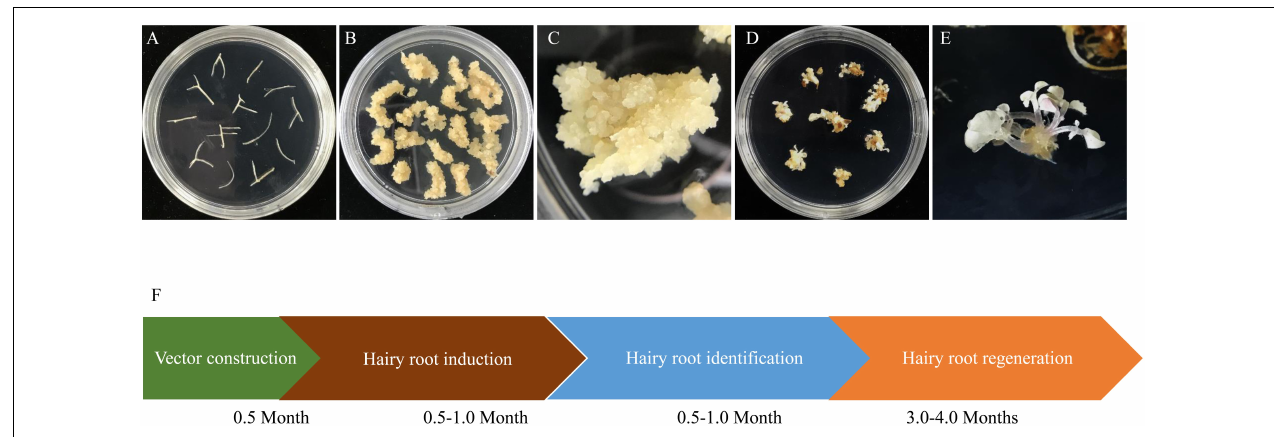
FIGURE 4 | Regeneration of biallelic and homozygous mutated hairy root lines. (A) A represented hairy root line (TL13) with homogenous editing on MtPDS were cut into 1–2 cm lengths and transferred into callus induction medium. (B) Calli induced from hairy root fragments. (C) Close-up image of hairy root calli. (D) Plantlets with biallelic or homozygous mutations regenerated from hairy root calli. (E) Close-up image of plantlets with biallelic or homozygous mutations regenerated from hairy root calli. (F) Schematic of the process for obtaining biallelic and homozygous hairy root lines and the time required for each step. The entire process from vector design to the recovery of plantlets took approximately 4.5–6.5 months.